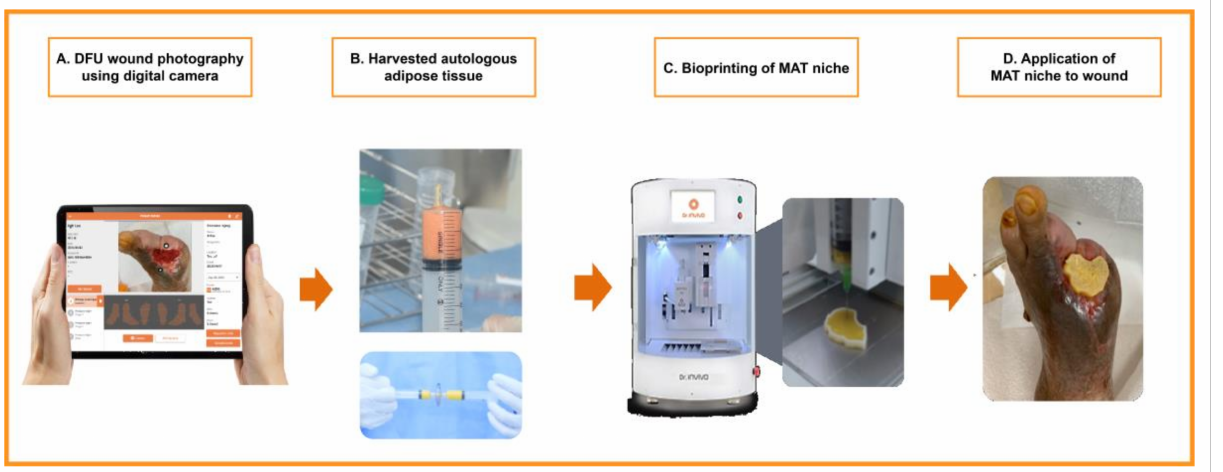
Figure 2. A diagram showing the flow of patients in the treatment group in this